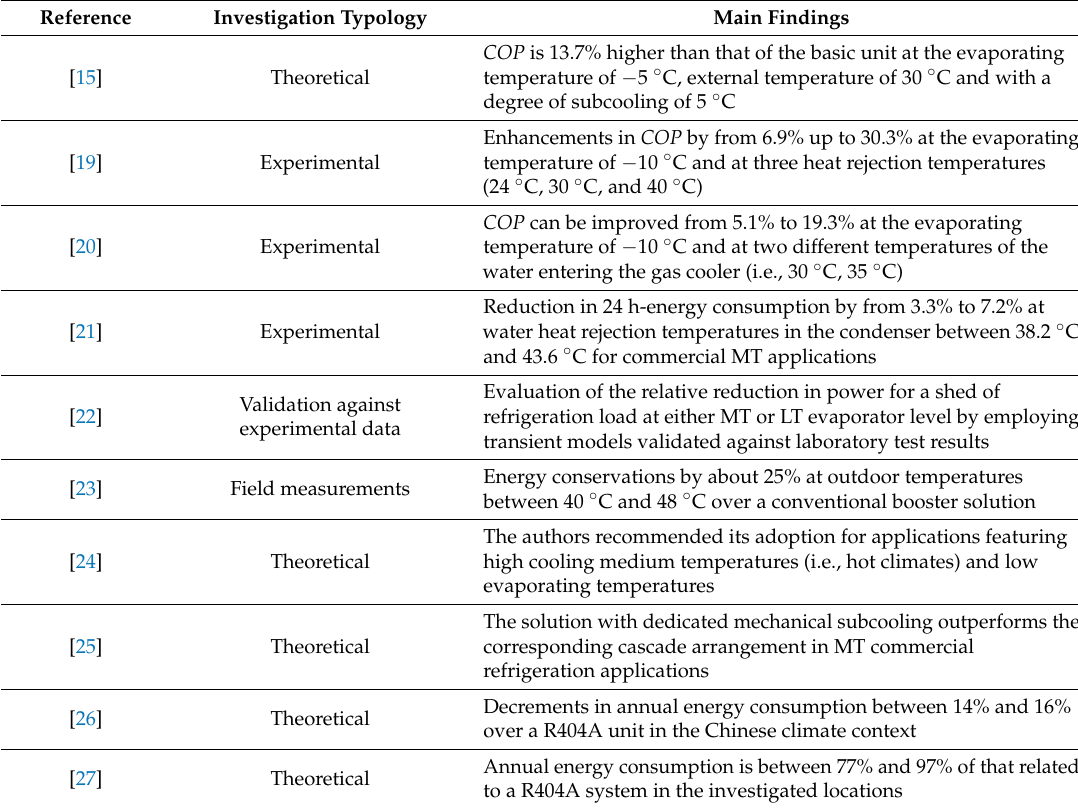
Table 1. Findings of the main investigations associated with transcritical R744 supermarket refrigeration systems with dedicated mechanical